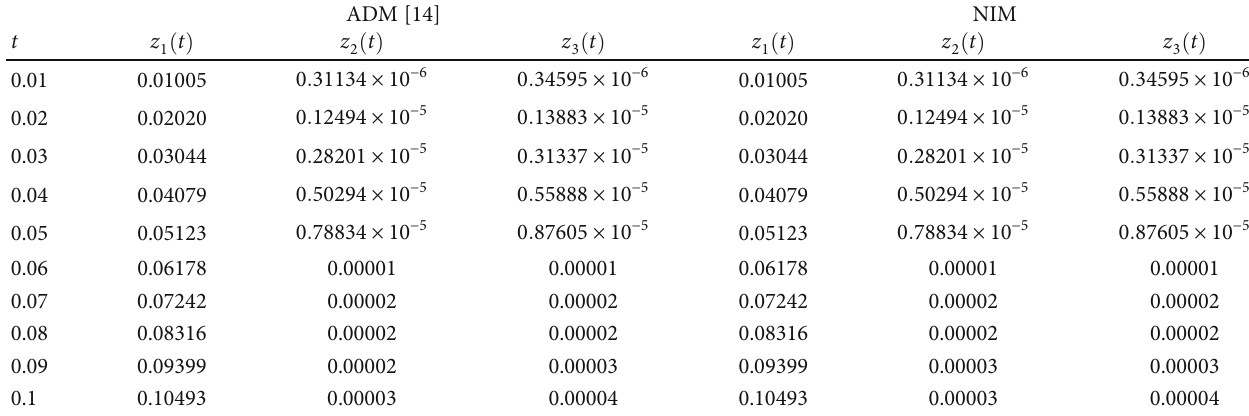
Table 5: Numerical comparisons between ADM and NIM for the sinusoidal input model.